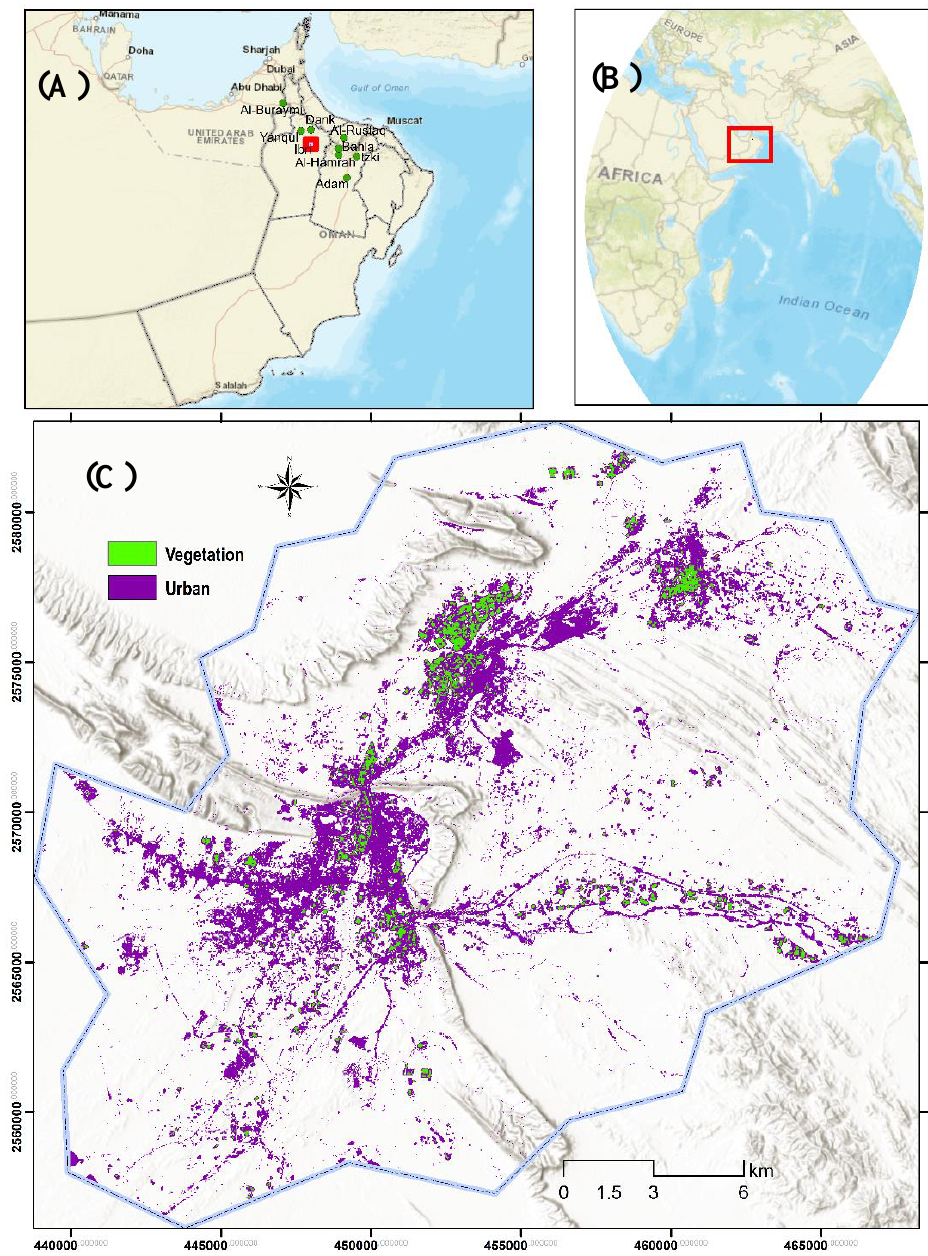
Figure 1. Location of the study area: The upper-left map illustrates the location of the city of Ibri within Al-Dhahra Governorate ( A ), while the location of Oman is presented in ( B ). The bottom map shows the spatial distribution of vegetation and urban area in 2020 ( C ).